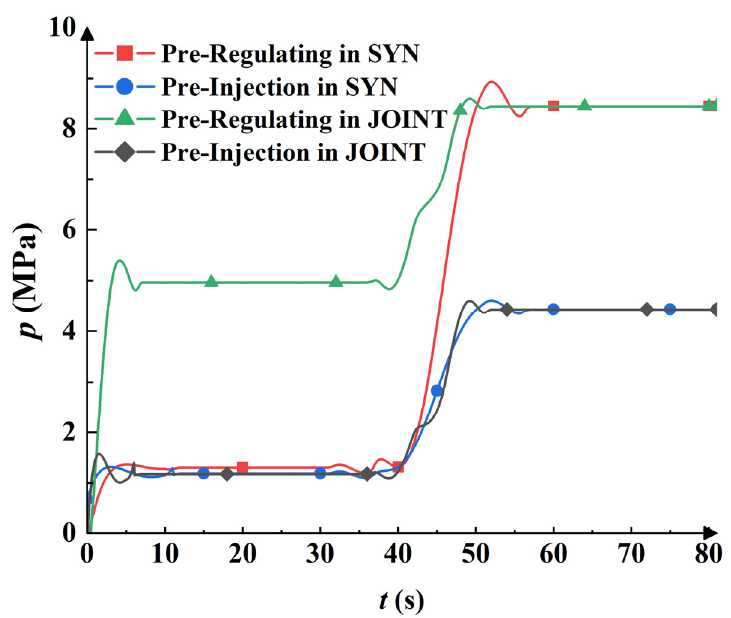
Figure 19. Comparison of pre-regulating and pre-injection pressure in Scheme SYNC vs. Scheme JOINT.